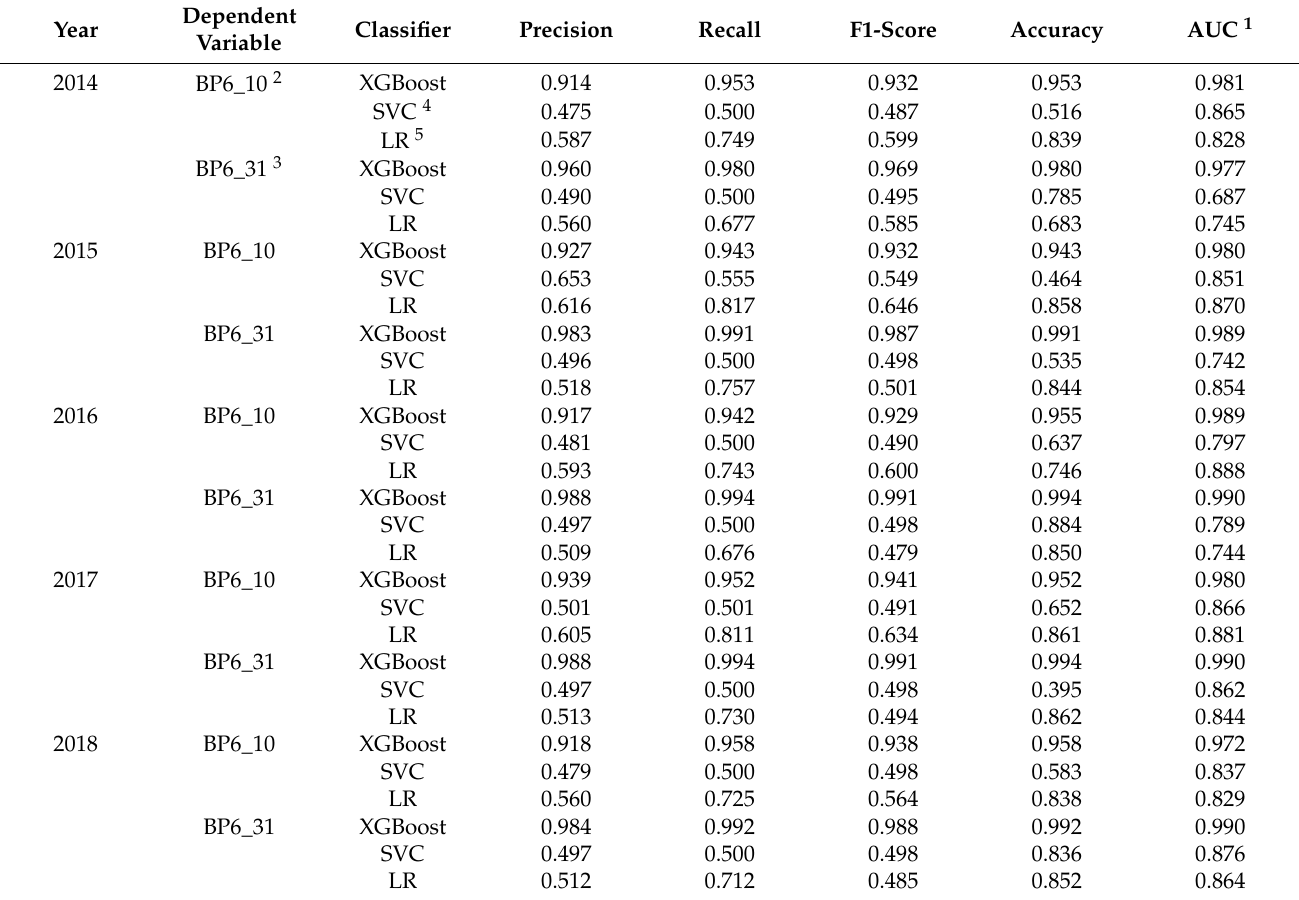
Table 6. Classification performance results for classifiers with yearly datasets